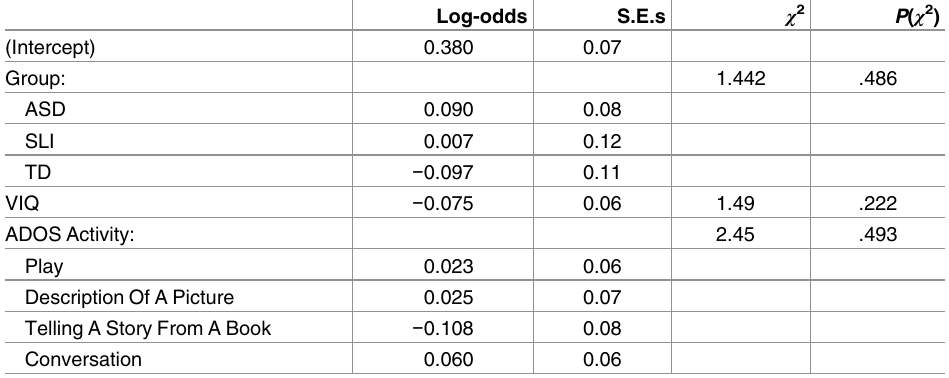
Table 5. Results for regression on repetitions versus